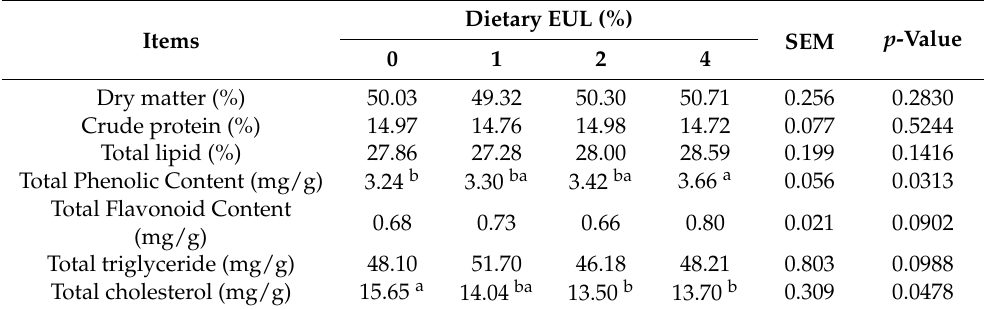
Table 5. Effect of dietary EUL on chemical composition of egg yolk for laying ducks (Fresh matter basis) 1